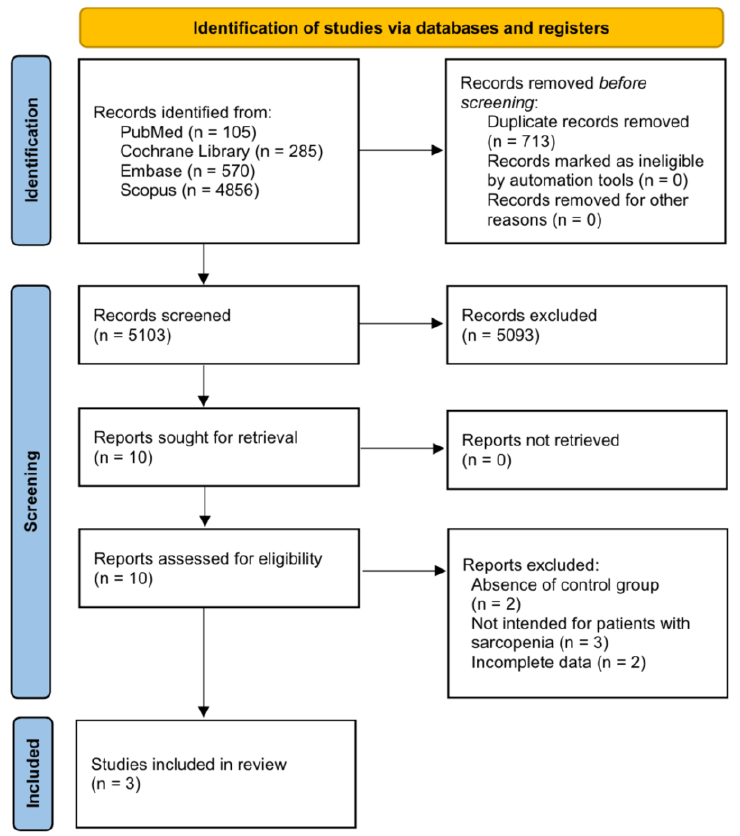
Figure 1. Flow diagram showing the search results of the meta-analysis.